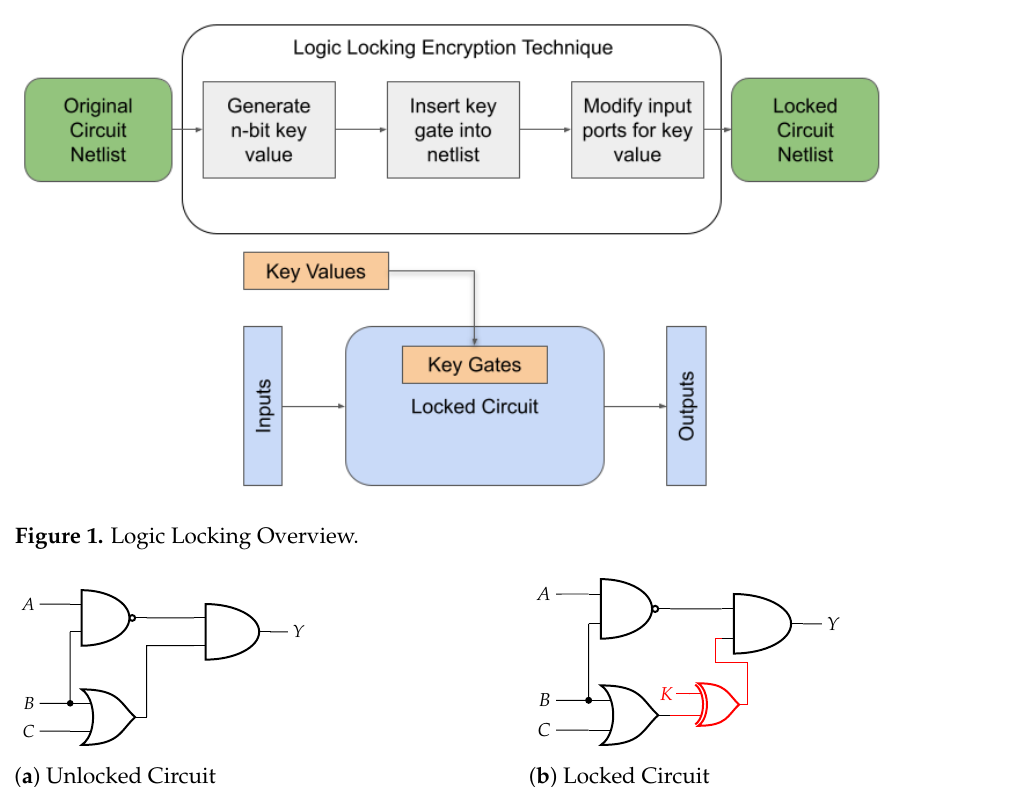
Figure 2. An example of logic locking